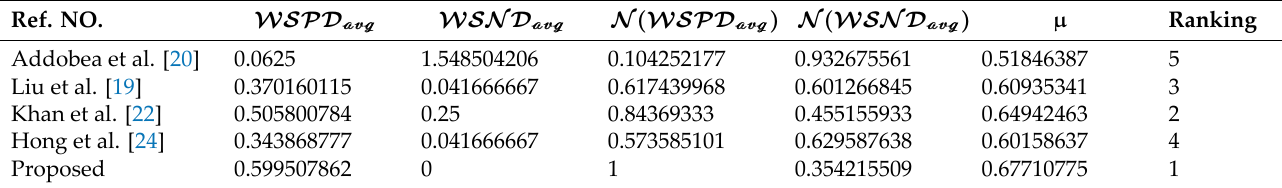
Table 14. Ranking under the selected